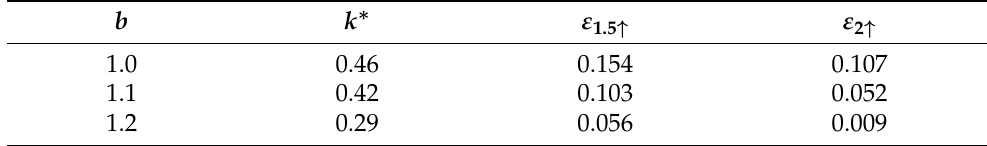
Table 1. Critical noise intensity values for 1.5 ↑ pattern ( ε 1.5 ↑ ) and 2 ↑ pattern ( ε 2 ↑ ) in Systems (1),